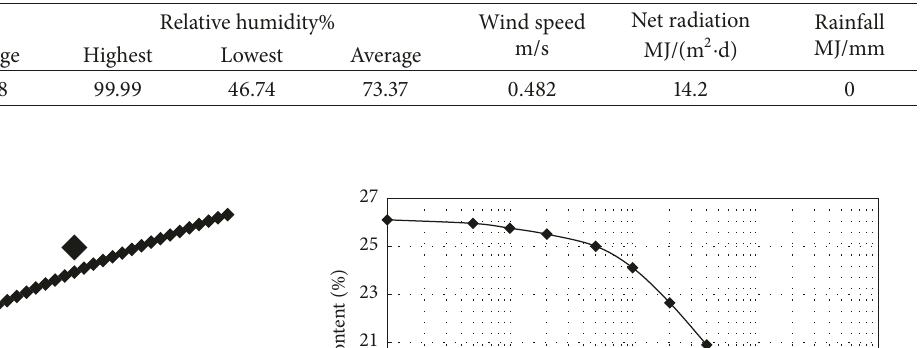
Table 2: Weather data of some region in China.